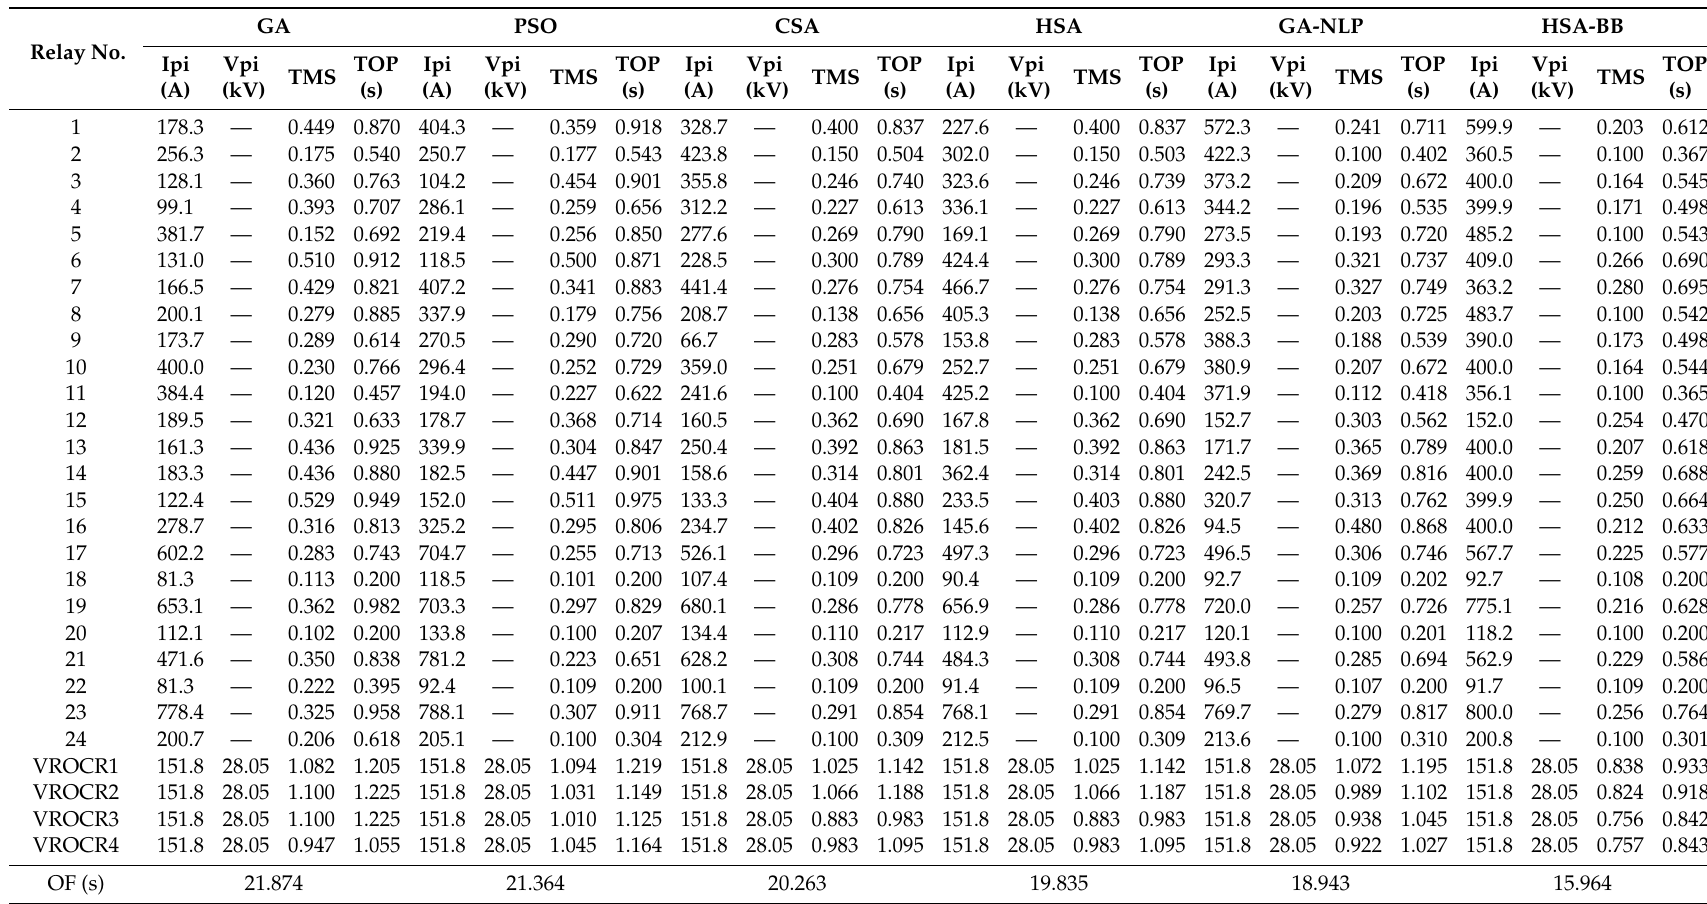
Table 8. Results of 9-bus